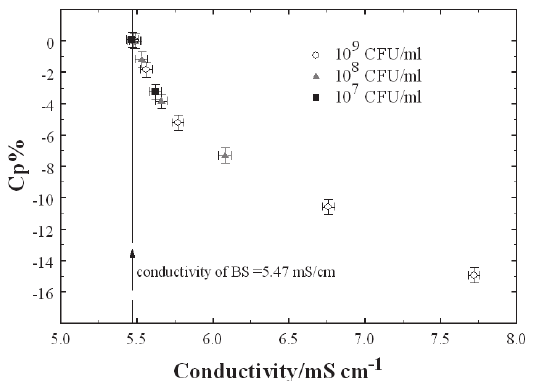
Fig.5: Dependence of C p % with the supernatant conductivity.